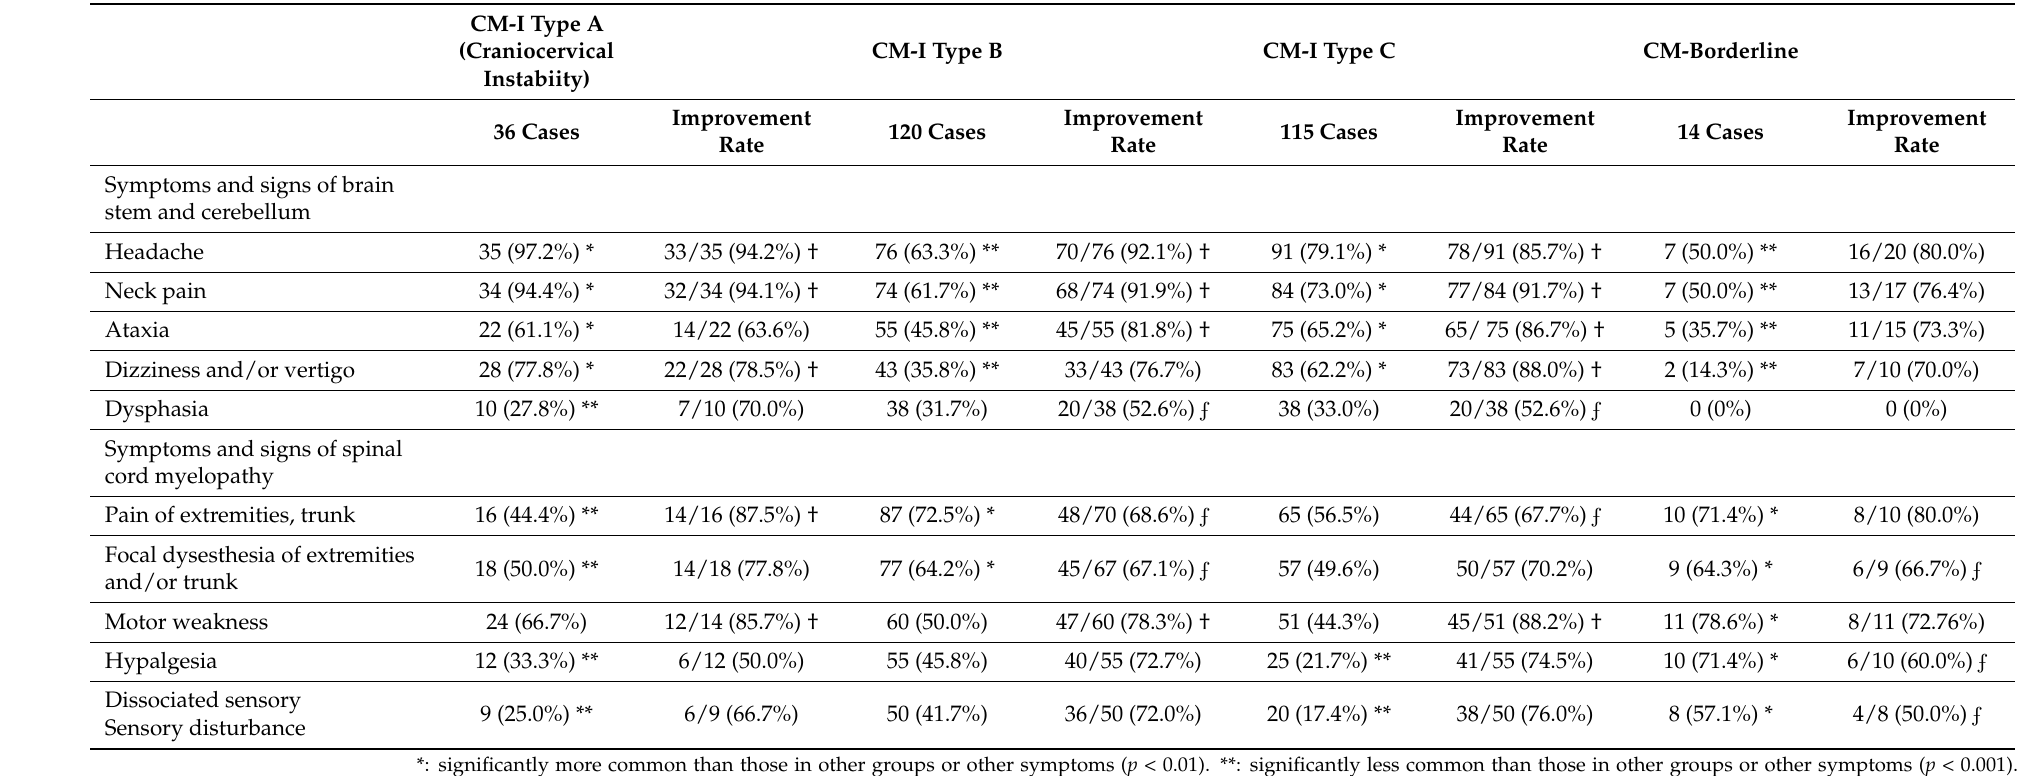
Table 3. Neurological symptoms and signs, and their